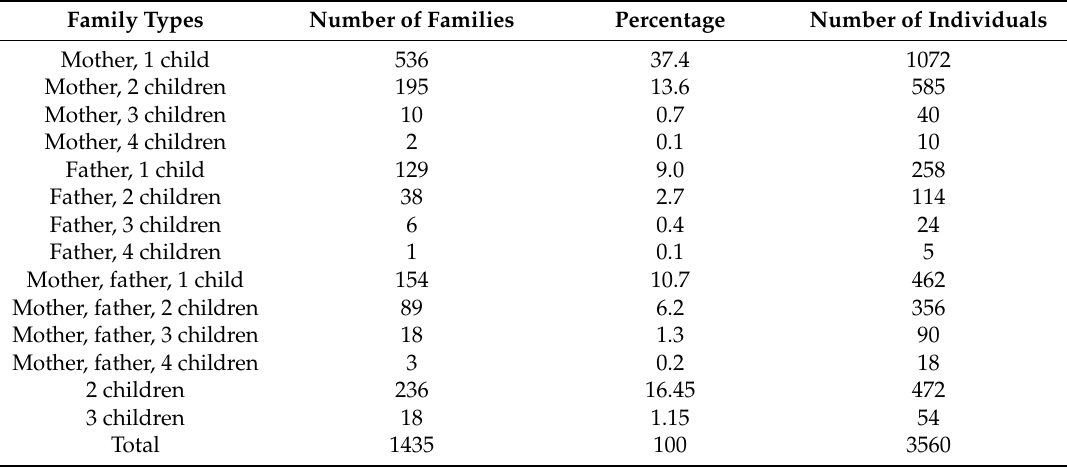
Table 1. Distribution of family types in the study